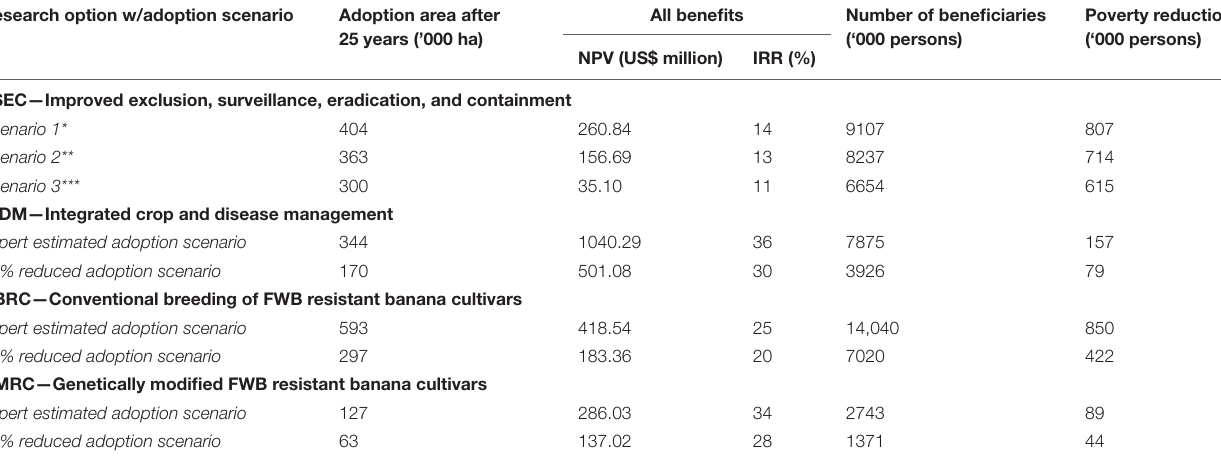
TABLE 5 | Results of ex ante assessment: adoption area, NPV and IRR, beneficiaries, and poverty reduction. Research option w/adoption